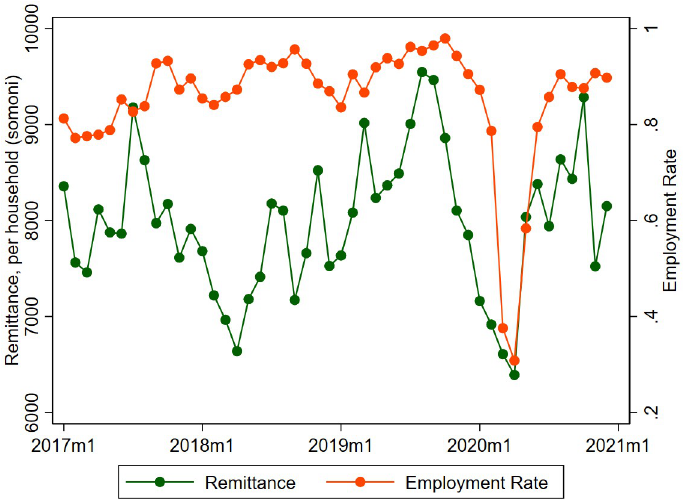
Fig 4. The impact of the COVID 19 on remittance and employment. This graph shows the remittance inflows and employment rate of migrants, in terms of ratio to population, using a three-month moving